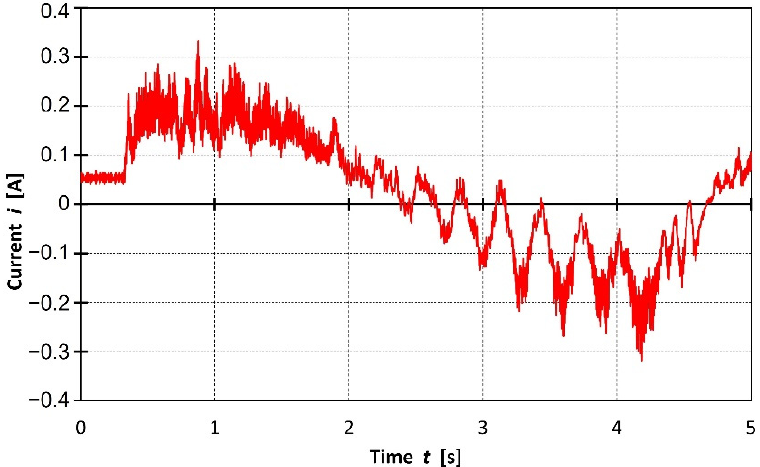
Figure 25. Courses of the voltage controlling the motor.